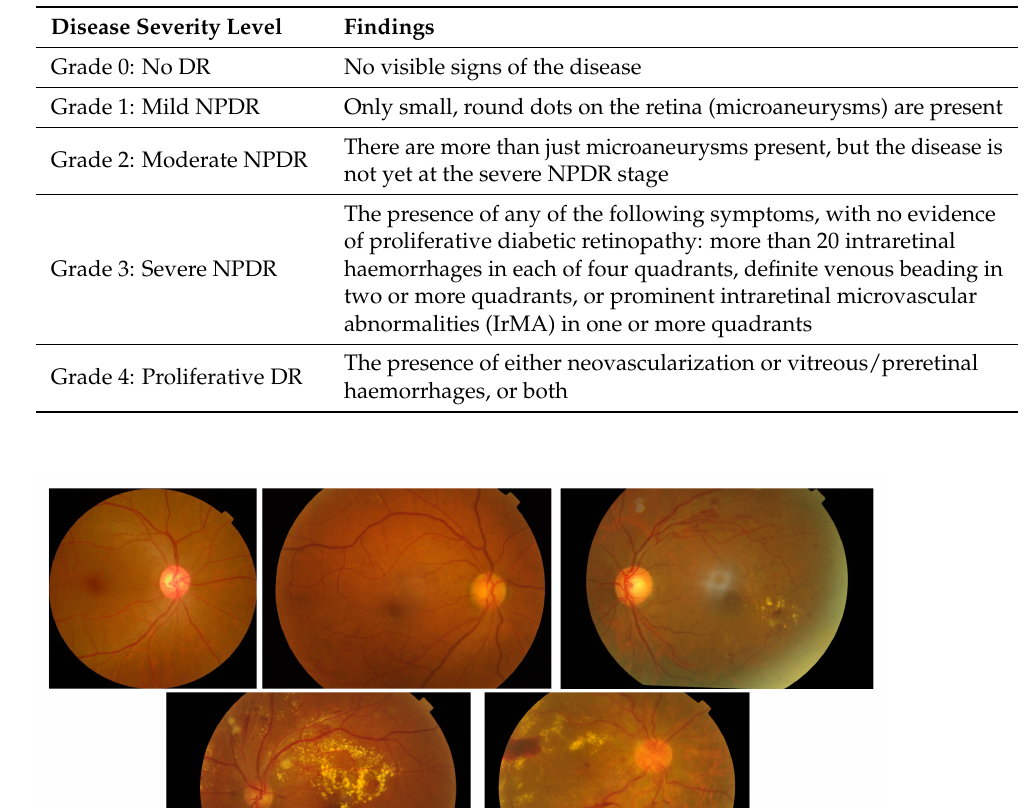
Table 1. DR progression stages.